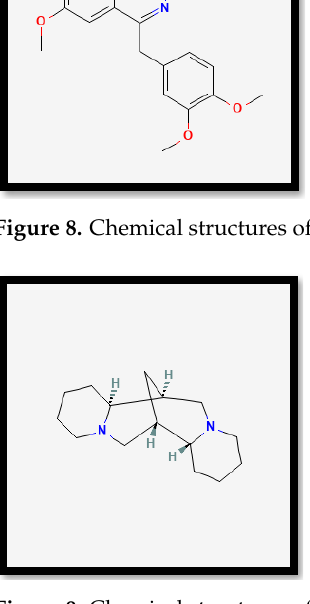
Figure 9. Chemical structures of sparteine.